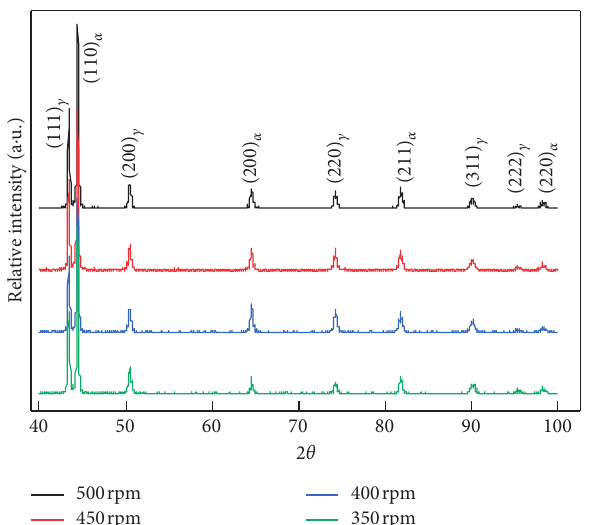
Figure 12: X-ray diffraction patterns for the welds formed at various rotation speeds.